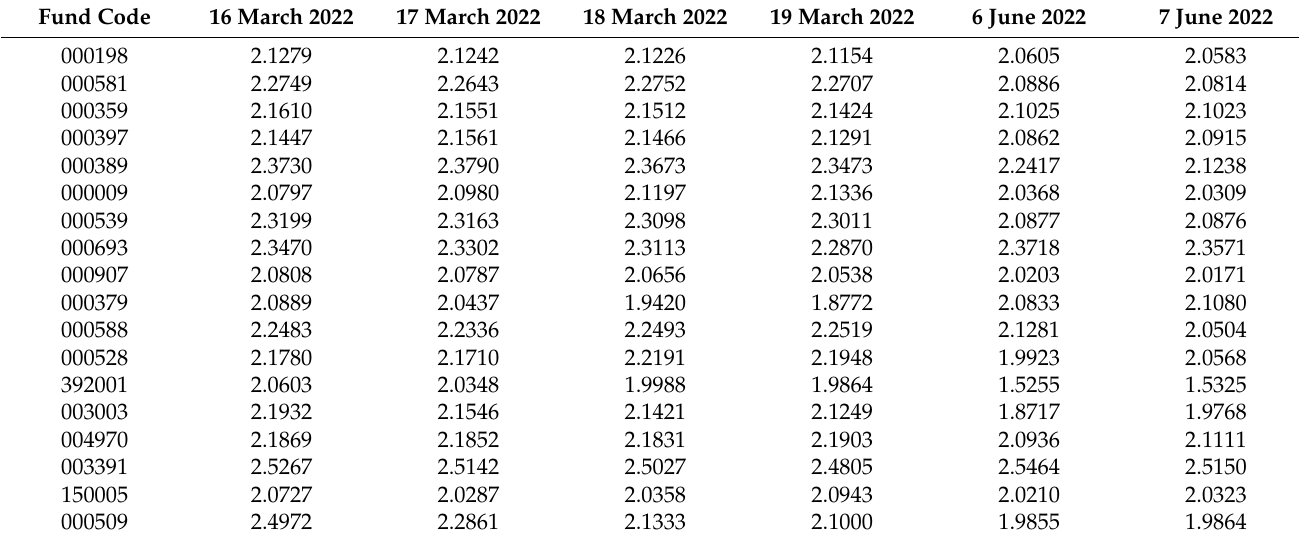
Table 4. The forecast results of the seven-day annualized return rates (%).